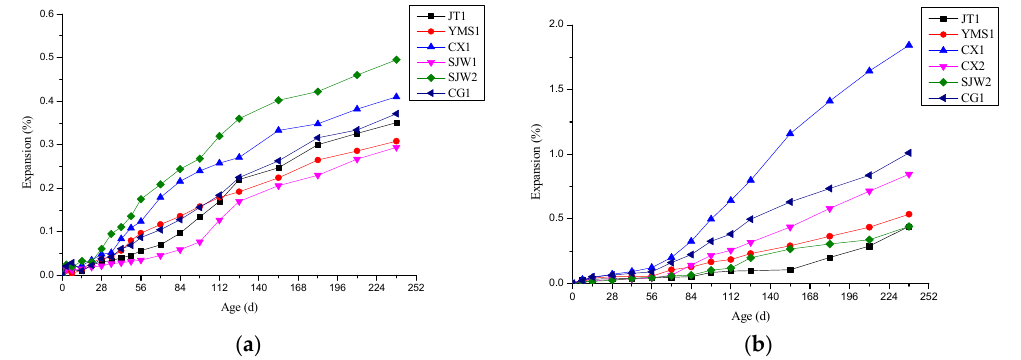
Figure 4. Expansion rate curve of specimens cured in tetramethylammonium hydroxide (TMAH) solution: ( a ) concrete microbars, ( b ) rock prisms.